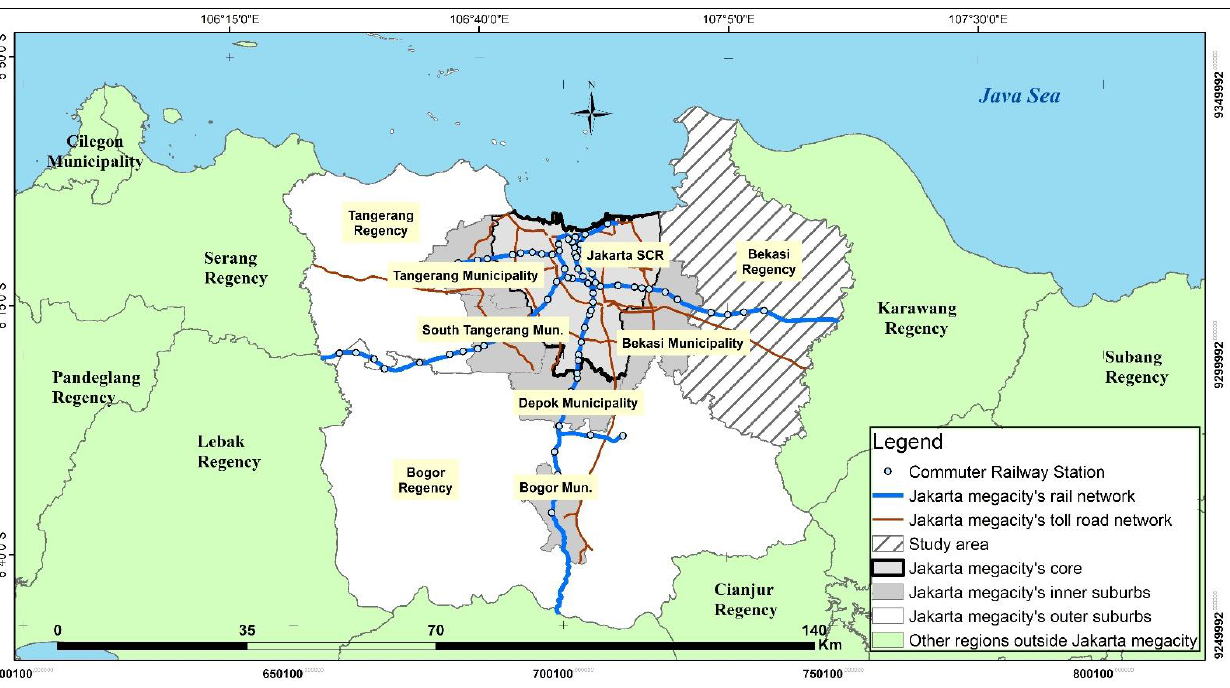
Figure 1. Bekasi Regency’s location in the Jakarta megacity and its surrounding areas.